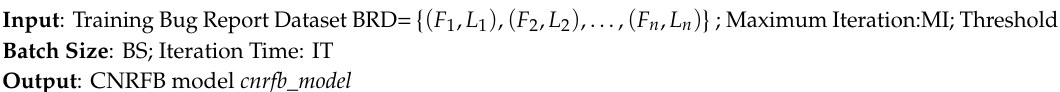
Algorithm 1: The Training Process of CNR